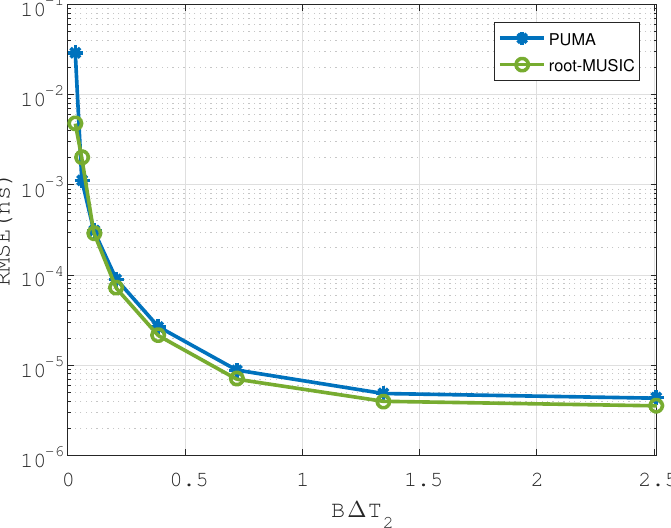
Figure 4. RMSE versus B ∆ T 2 , Scenario 1, SNR = 25dB, N = 150, B =